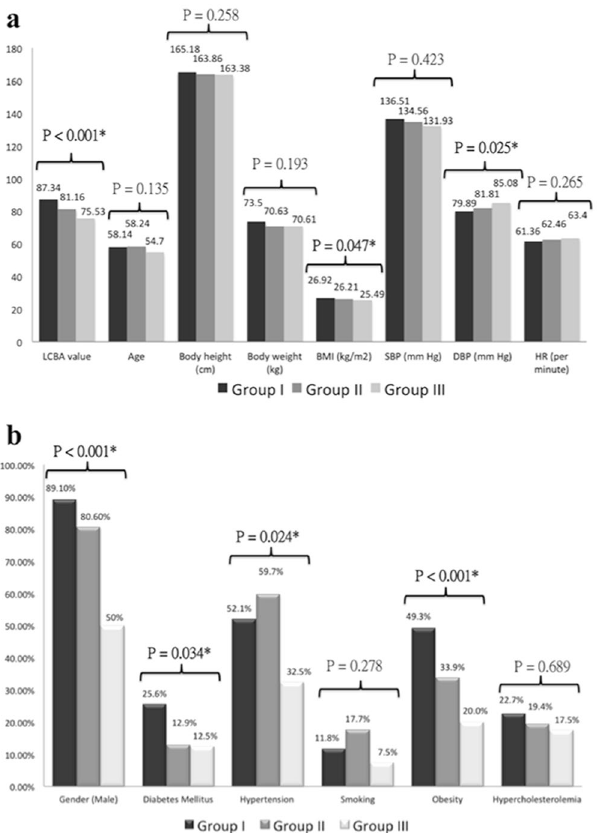
Figure 3. Comparison of the conventional risk factors for coronary artery disease and the LCBA values among the three groups of patients with respect to ( a ) continuous variables and ( b ) categorical variables. BMI = body mass index, SBP = systolic blood pressure, DBP = diastolic blood pressure, HR = heart rate. The asterisk ( * ) denotes statistical